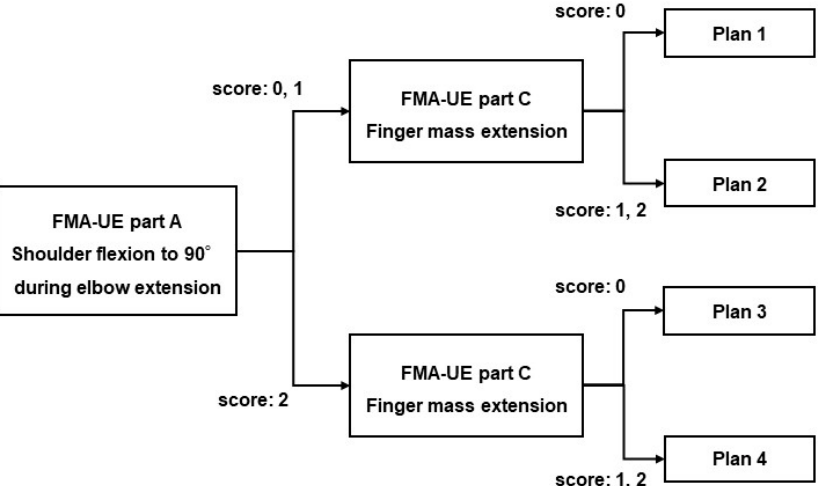
Figure 2. Chart of procedures for determining a functional practice plan. FMA-UE, Fugl-Meyer assessment of the upper extremity. The FMA-UE Part A (shoulder flexion to 90 ◦ during elbow extension) and Part C (finger mass extension) scores, evaluated on the day of admission, are used to determine the plan of functional exercises. The functional exercise plans are classified from 1 to 4 according to the scores from the two tests.